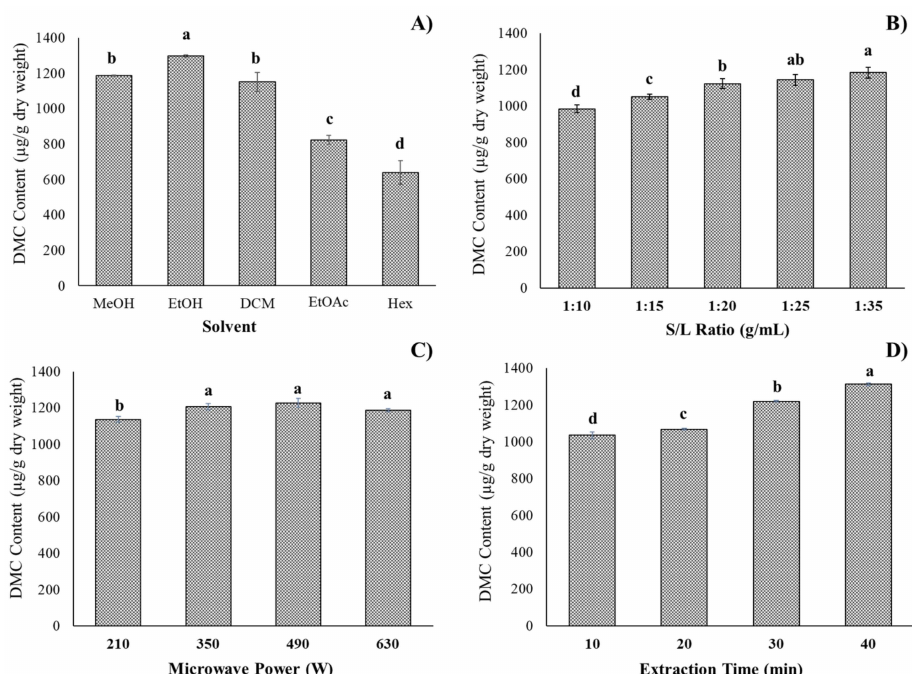
Figure 2. The effect of different types of solvent ( A ), solid-to-solvent ratio ( B ), microwave power ( C ), and microwave time ( D ) on DMC content from the fruits of Syzygium nervosum of MAE. Bar with the different letter show a significant difference ( p < 0.05) among